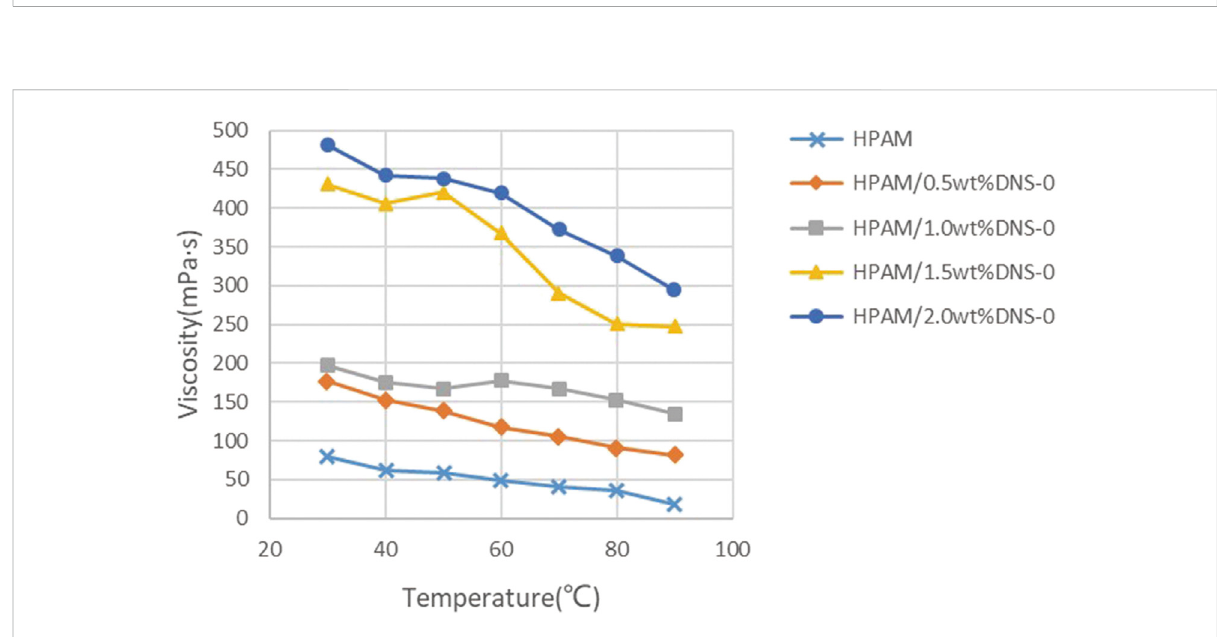
FIGURE 8 Viscosities of HPAM, and with addition of different concentration of silica NPs. Effect of temperature (based on Zheng et al., 2017).